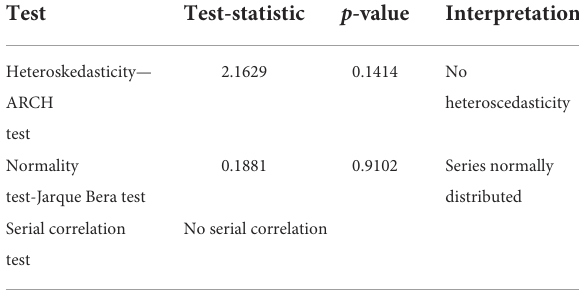
TABLE 6 Residual diagnosis